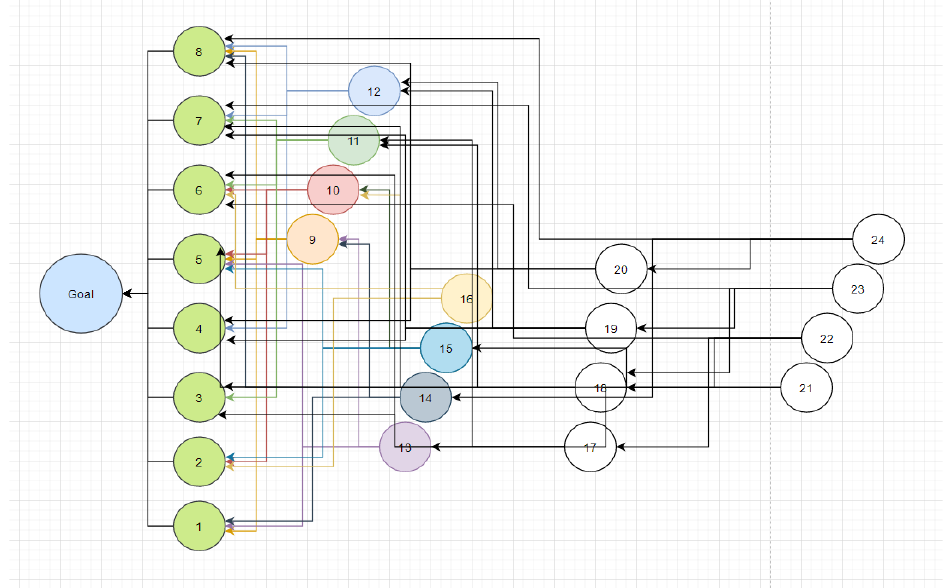
Figure 2. The illustration of the DP-like, layered-structure representation of the cells. The DP-based formula for calculating the shortest traveling distance is as follows: